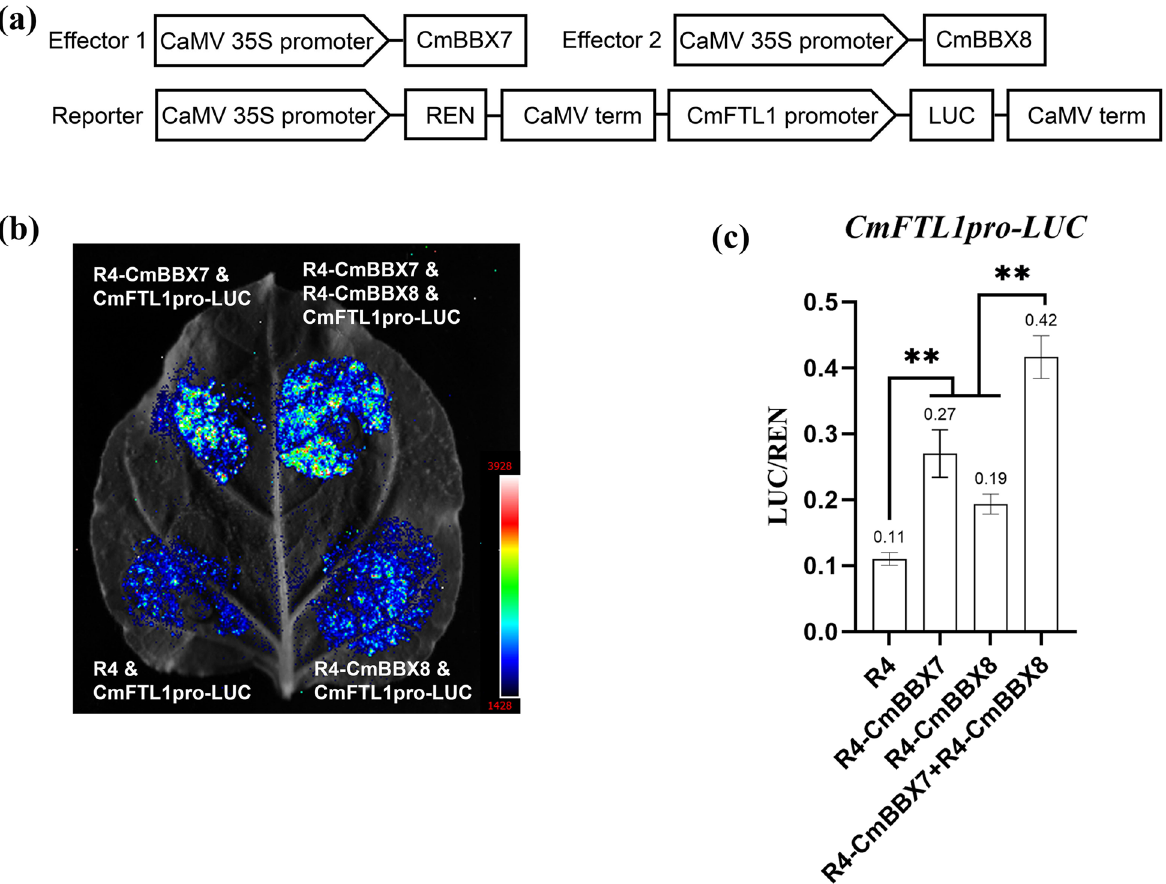
Fig. 6 CmBBX7 and CmBBX8 synergistically regulate CmFTL1 expression . a Effector and reporter vector construction diagrams for dual-luciferase assays. b Transient expression in N. benthamiana leaves of the pCmFTL1::LUC transgene. The graph shows the luminescence intensity. c The ratio of LUC to REN activity. Error bars indicate the standard deviations for six biological replicates. Significant differences are indicated with asterisks (** p < 0.01, ANOVA with Tukey’s post-hoc